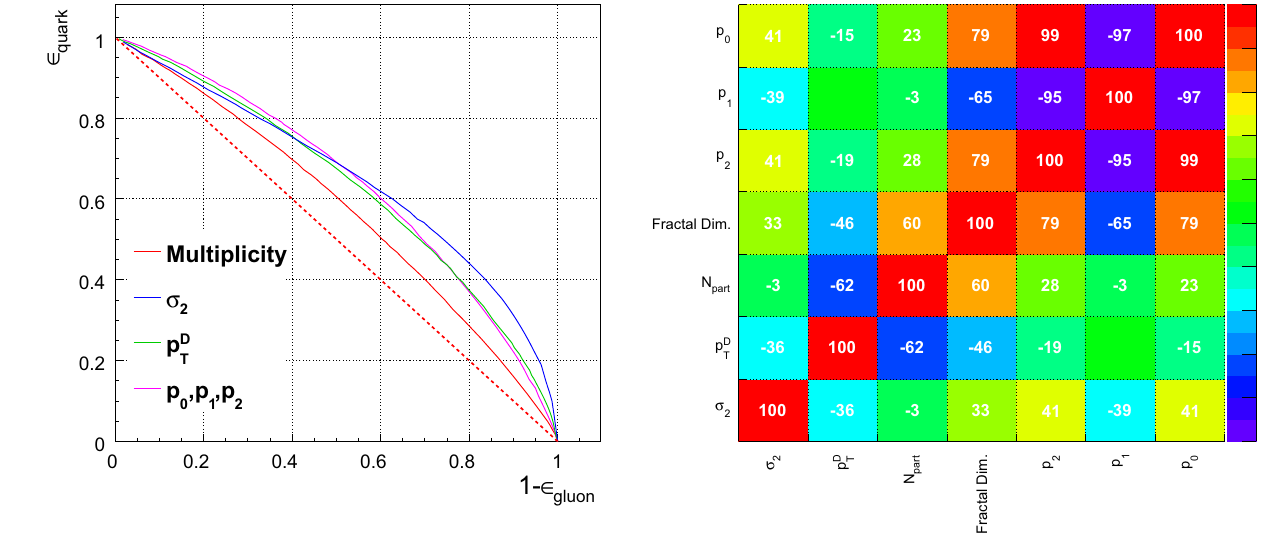
Right: linear correlation coefficients between pairs of variables, for quark jets (the values are similar for gluon jets). We see only weak correlations between the EFOs and the three existing QGD variables